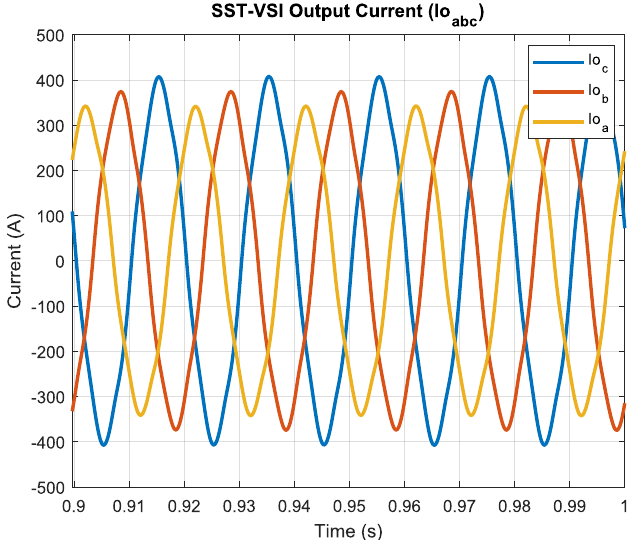
Figure 13. ( a ) SST-VSI output voltage without filter. ( b ) Filtered SST output voltage.